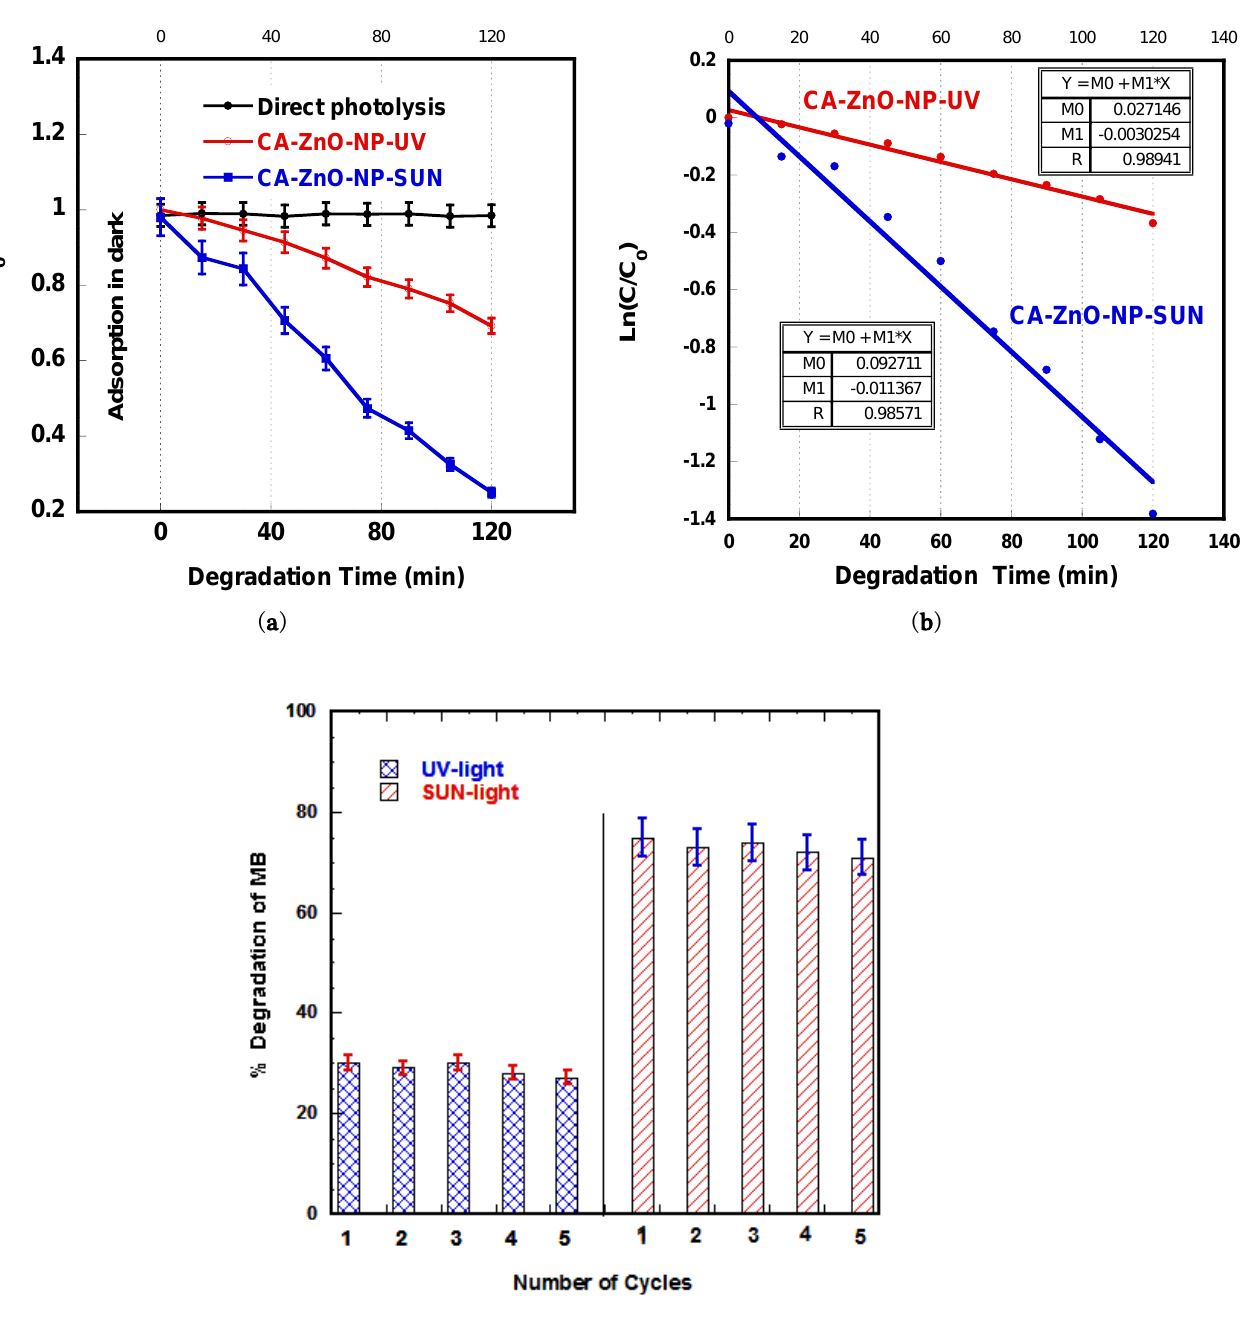
Figure 8. ( a ) Plots of C/C 0 vs. irradiation time for photocatalytic degradation of MB in the presence of CA-ZnO-NP membranes under UV-light and sunlight irradiation. ( b ) Plots of ln(C/C 0 ) vs. irradiation time for photocatalytic degradation of MB in the presence of CA-ZnO-NP membranes under UV-light and sunlight irradiation. ( c ) Cyclic runs showing the photocatalytic degradation of MB in the presence of CA-ZnO-NP membranes under UV-light and sunlight irradiation.